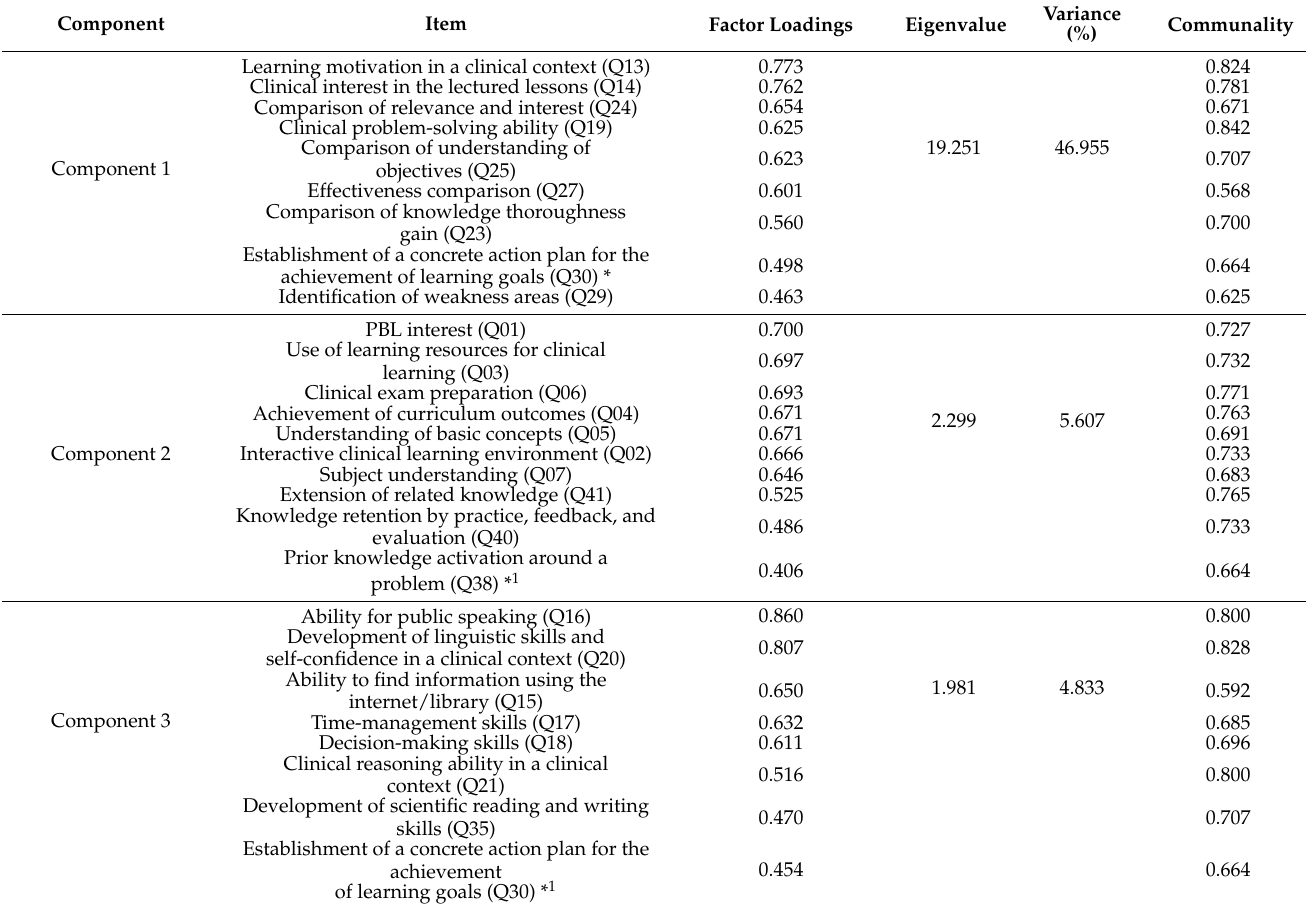
Table 4. Items overall distribution among components, after principal component analysis (PCA), according to the rotated component matrix, via Varimax with the Kaiser normalization method (cumulative variance (%) = 73.644, Kaiser–Meyer– Olkin (KMO) value =